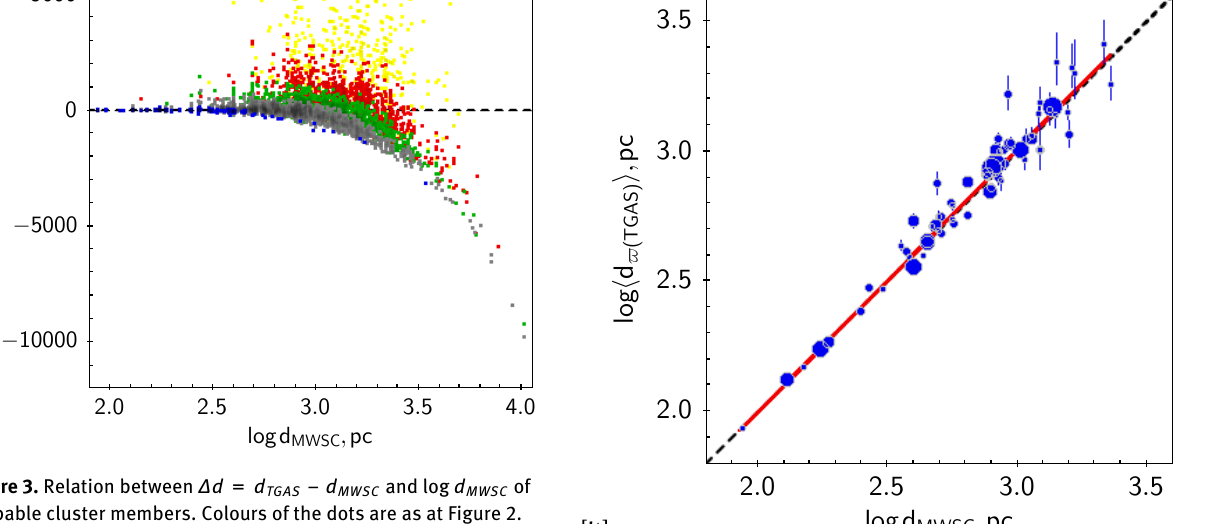
low-quality parallax dots clearly reside above zero indi- cating overestimated trigonometric distances due to a low- accuracy parallax bias.